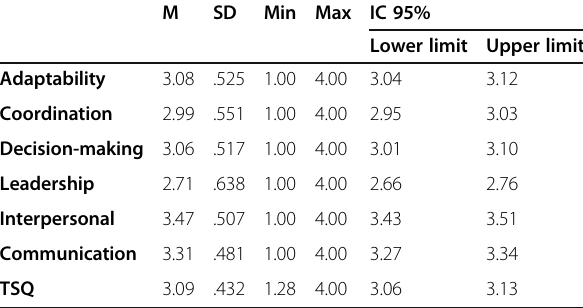
Table 2 Skill level in each of the factors and in total M SD Min Max IC